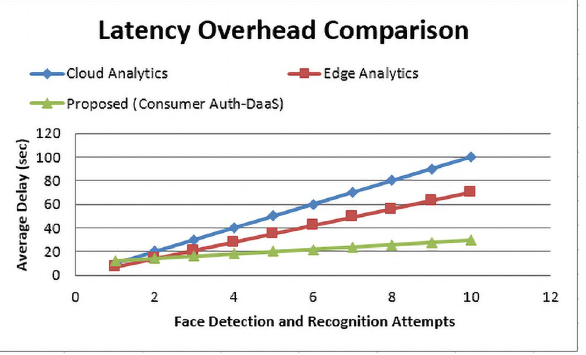
Fig 8. Latency overhead comparison among cloud computing, edge computing and the proposed hybrid computing based Consumer-Auth framework in terms of face recognition attempts.